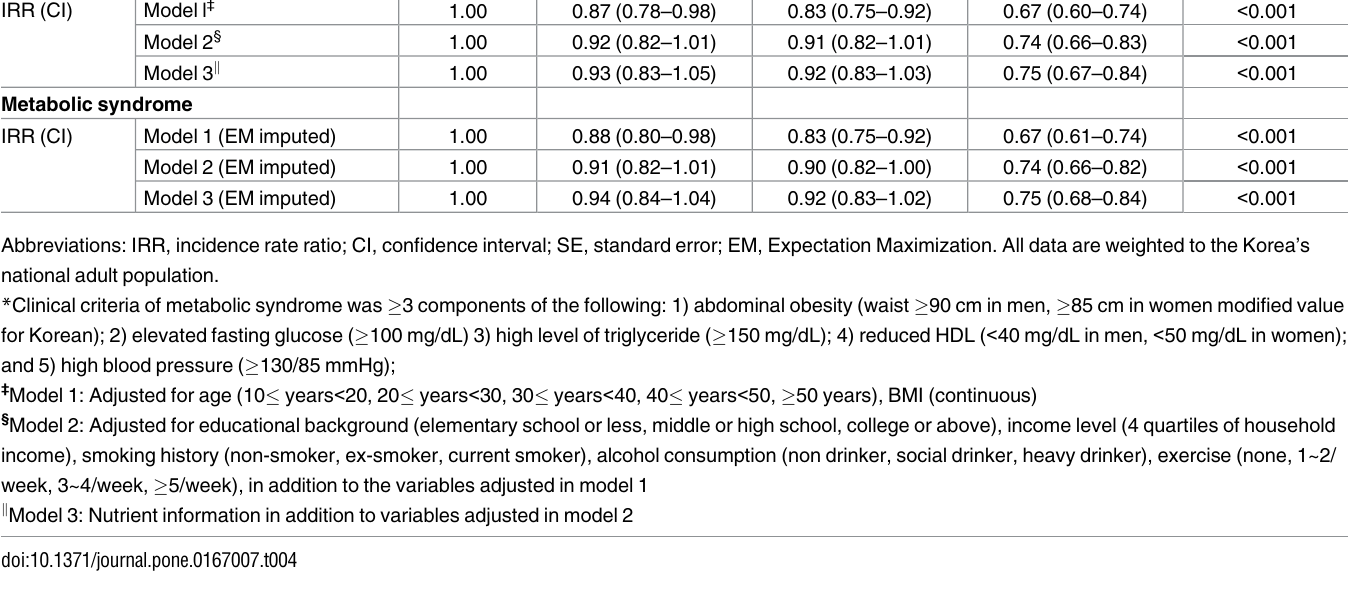
Table 4. The prevalence of metabolic syndrome by the frequency of coffee consumption after imputing for missing information. Frequency of coffee consumption p for trend ~ 0 cup > 1